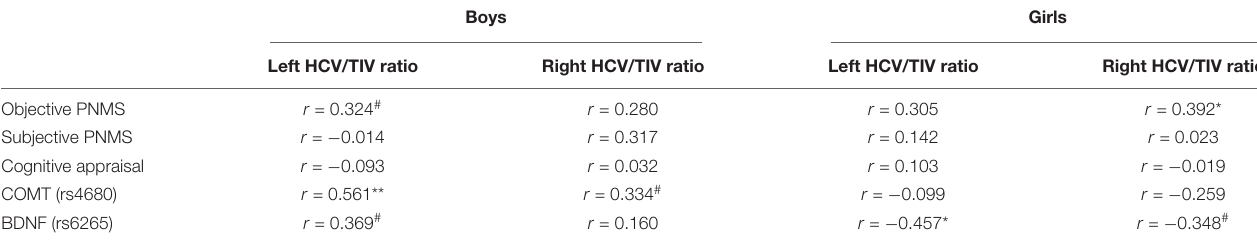
TABLE 4 | Associations between PNMS and genotypes with HCV/TIV ratios in boys and girls.